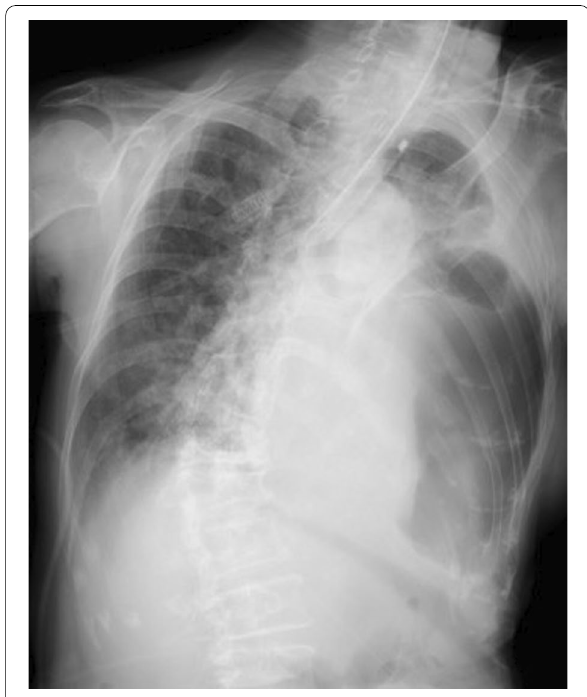
Fig. 1 Midline shift of mediastinum. Initial chest radiograph showed an air image in the left middle and lower lung fields